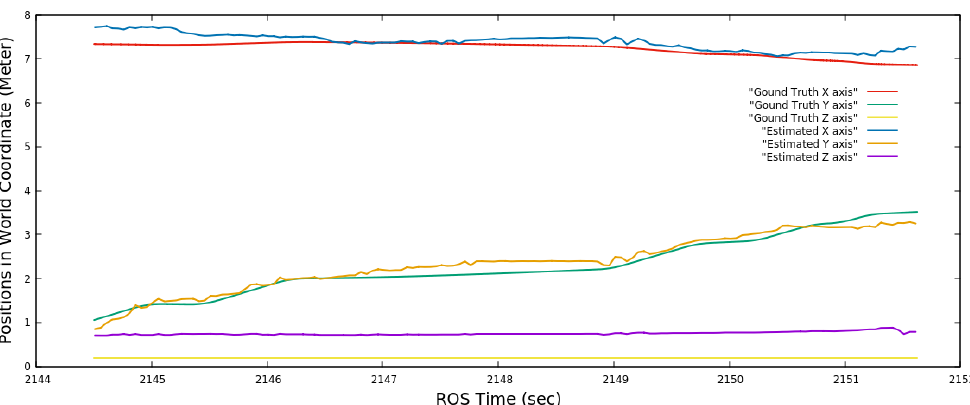
Figure 17. Absolute positional estimation of Husky2 in the world coordinate frame by the proposed method against the ground truth of the experiment presented in Section 4.2.2. The estimation curve closer to the corresponding ground truth curve is more